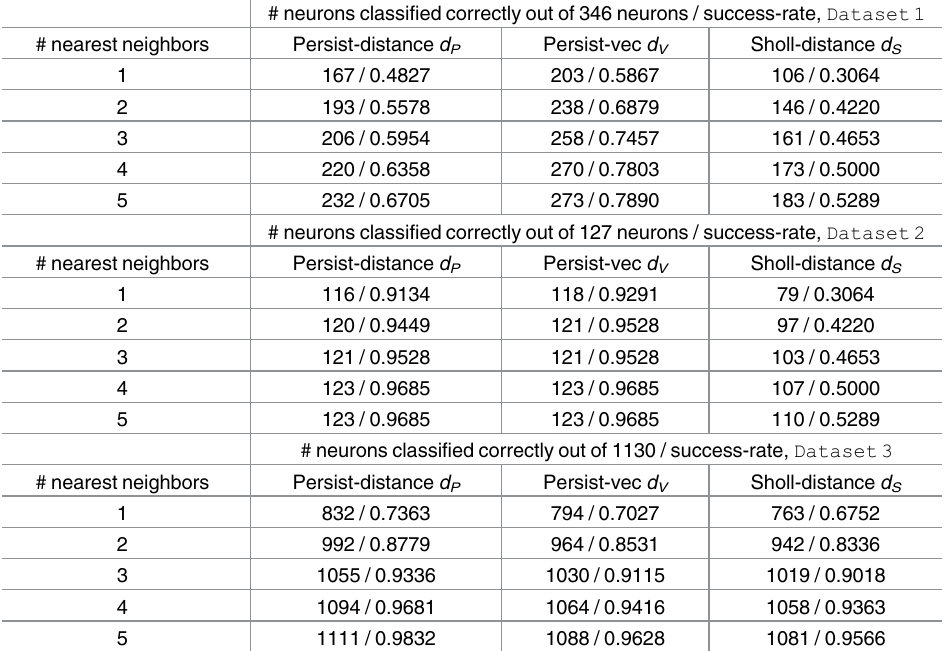
Table 1. Leave-one-out cross validation for k -nearest neighbor classification rate where k = 1, 2, ... , 5. # neurons classified correctly out of 346 neurons / success-rate, Dataset1 # nearest neighbors